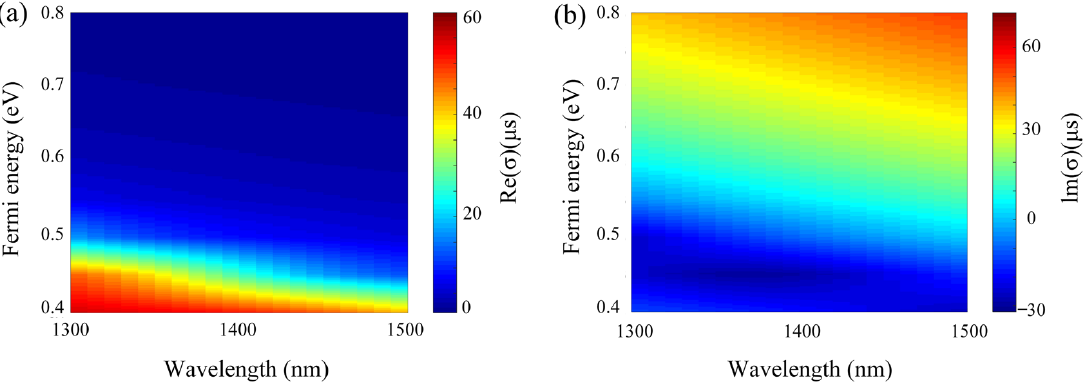
Figure 4. The wavelength dependent ( a ) the real part ( b ) the imaginary part of graphene conductivity with different Fermi energies.